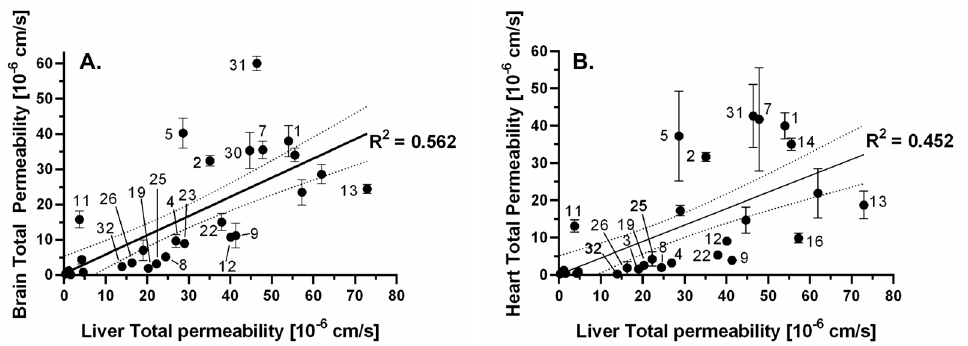
Figure 11. Linear regression between total permeabilities (n = 3), related to liver total permeability: ( A ) brain and ( B ) heart. The compounds are numbered as in Figure 2D.